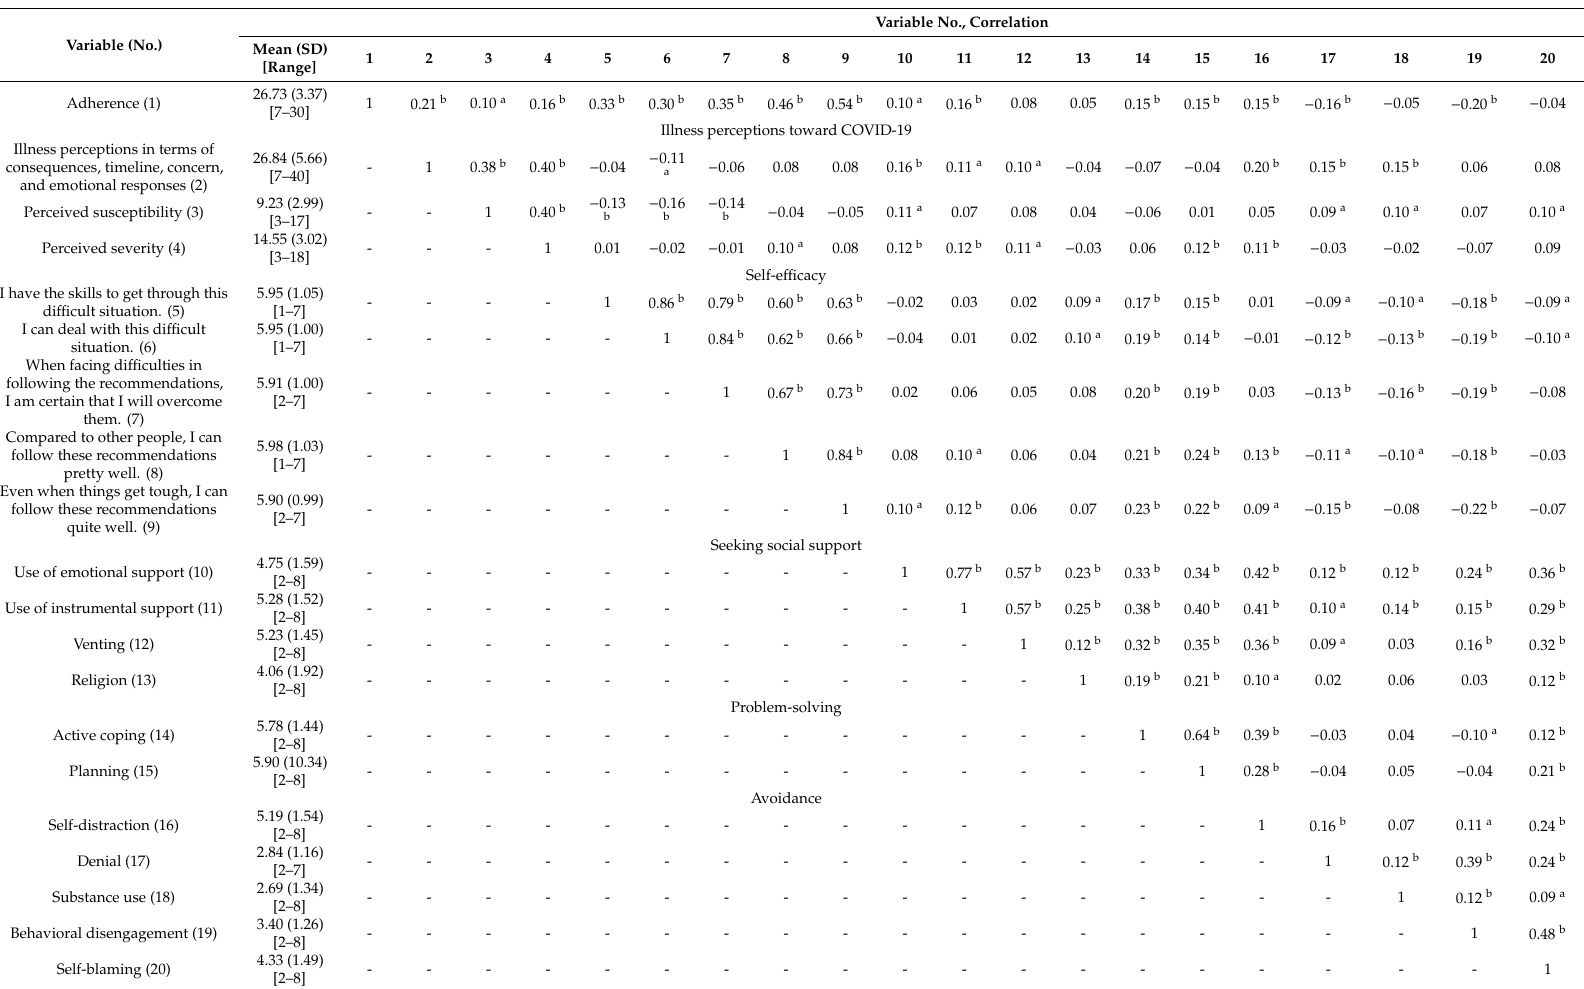
Table 2. Means and correlations for all study